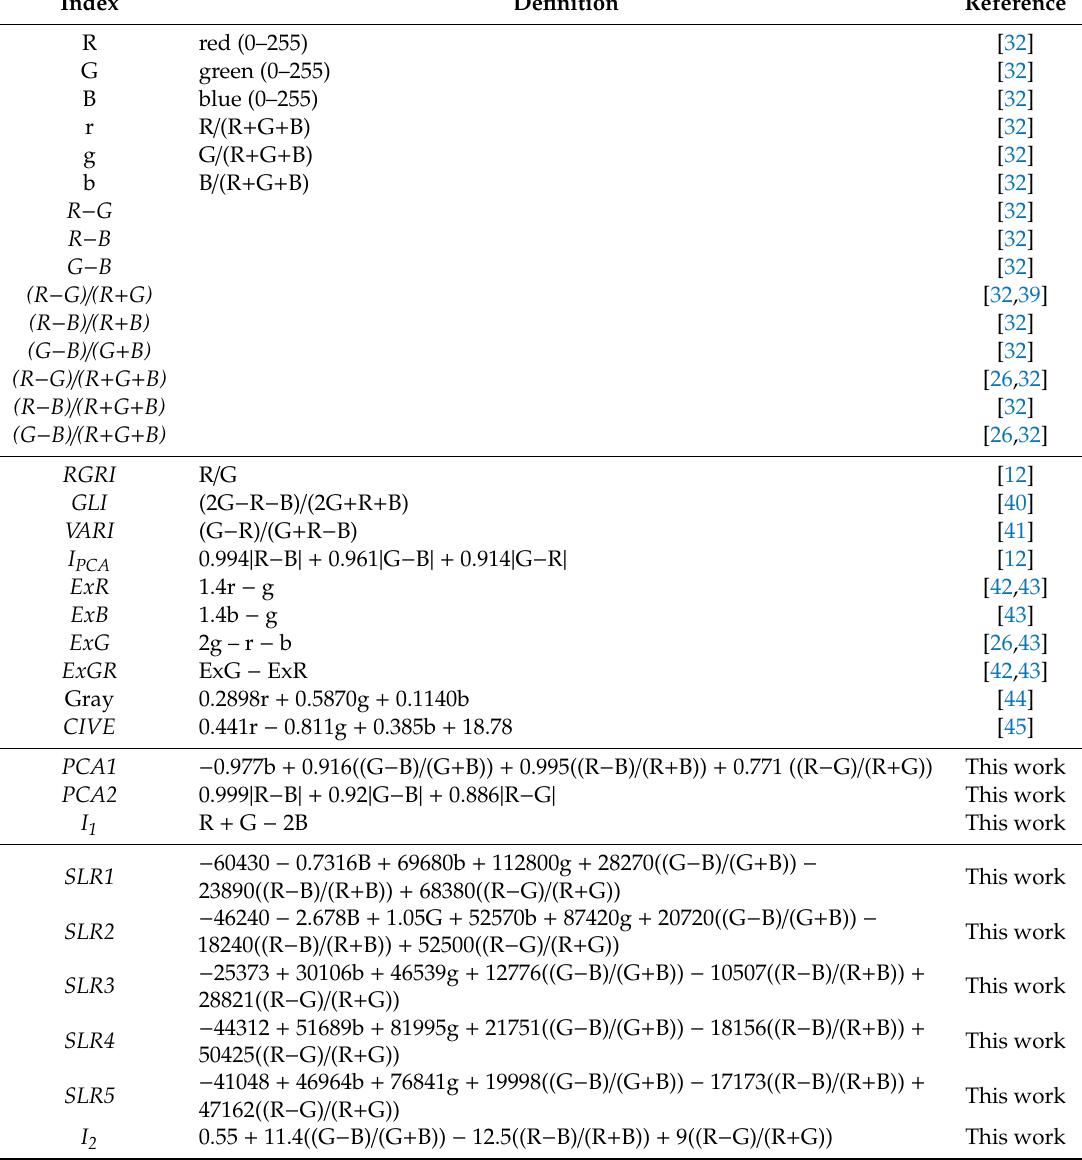
Table 1. List of the color vegetation indices considered in study, including their equations and